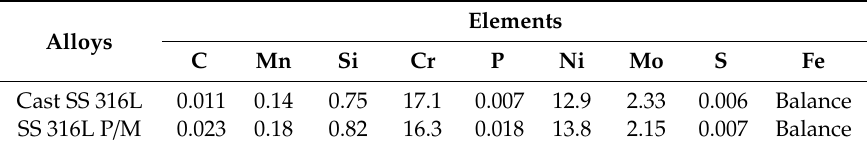
Table 2. 316L stainless steel (SS) composition (wt.%)